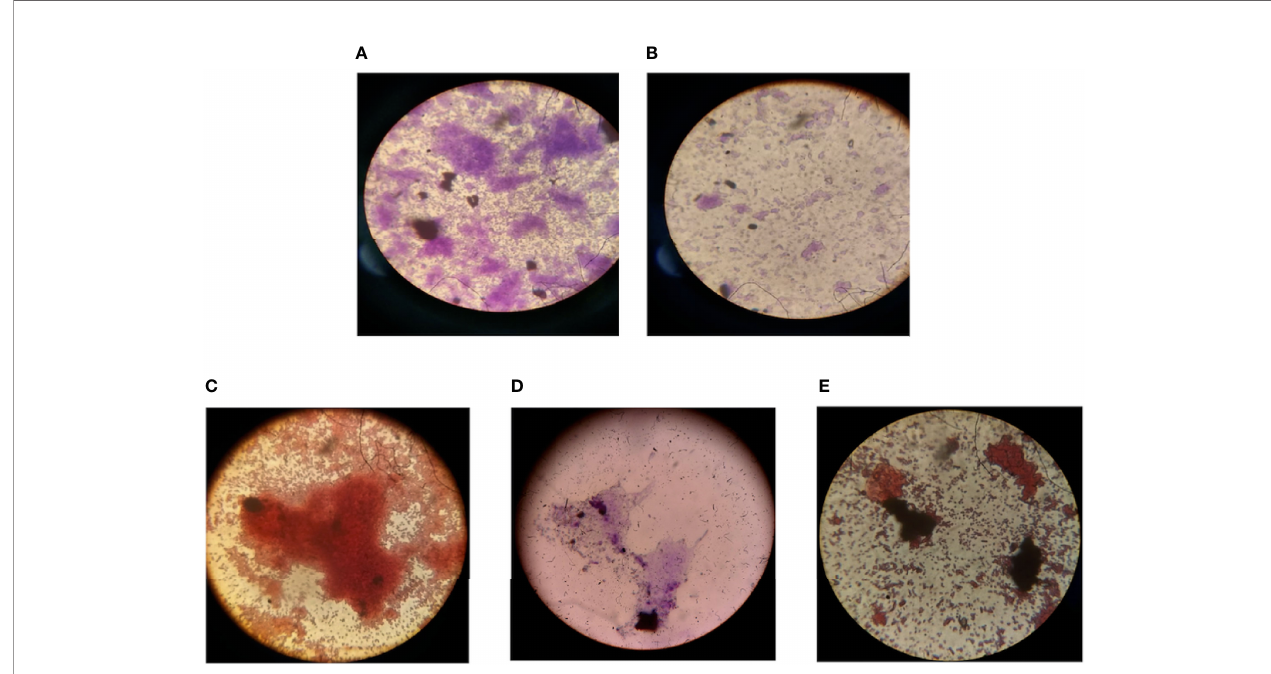
FIGURE 5 | Microscopic analysis of the effect of compounds on mixed bio fi lm. (A) Bio fi lm formed by mixed microbes (S.a, K.p, E.c, P.a, and C.v). (B) Bio fi lm formation inhibition by selected compound extracellular polymeric substances (EPS) extraction and analysis. (C) Carbohydrate. (D) Protein. (E) Lipid content of the bio fi lm EPS. S.a, Staphylococcus aureus ; K.p, Klebsiella pneumoniae ; E.c, Escherichia coli ; P.a, Pseudomonas aeruginosa ; C.v, Chromobacterium violaceum .